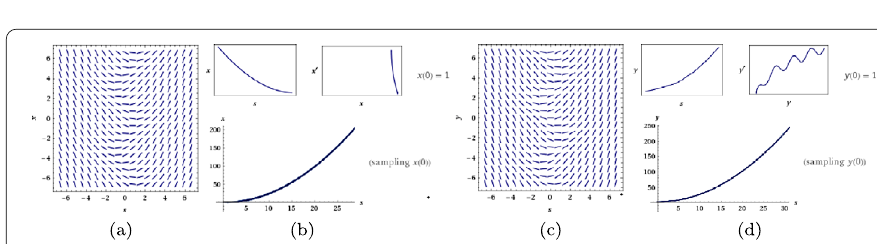
Figure 3 Solutions of (10) for the value of σ (1 – μ ) = 0.2, indicating the sample solution